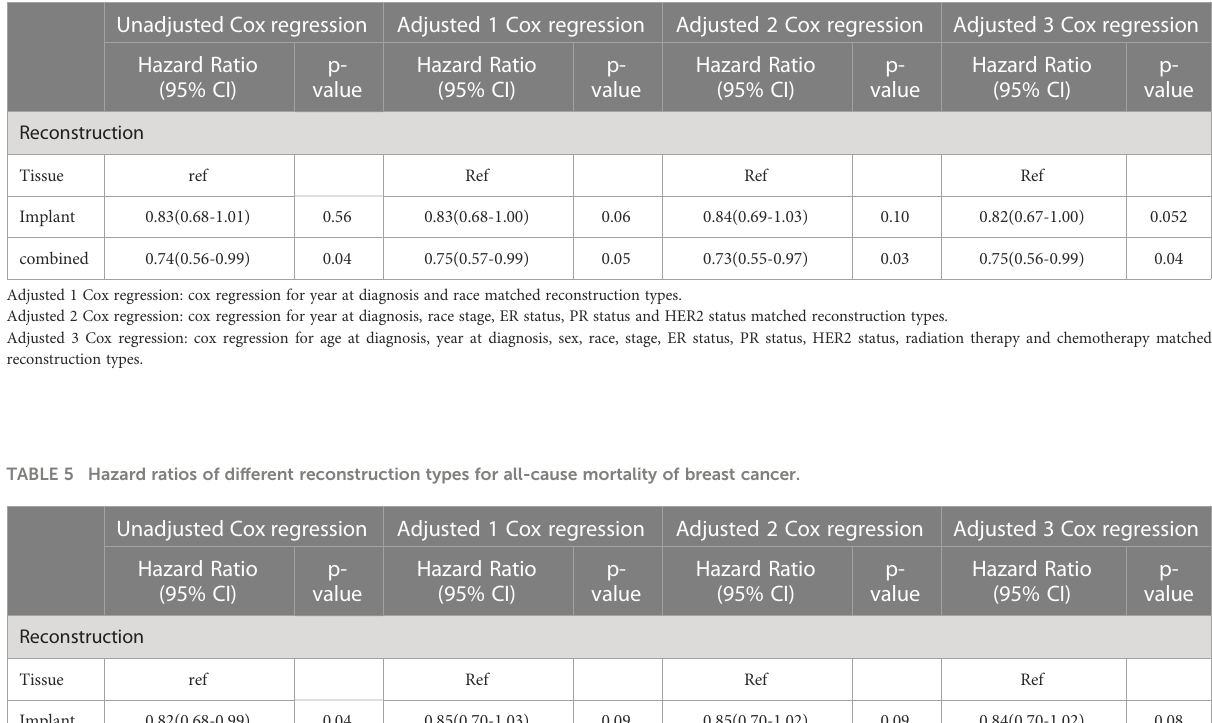
TABLE 4 Hazard ratios of different reconstruction types for the cancer speci fi c mortality of breast